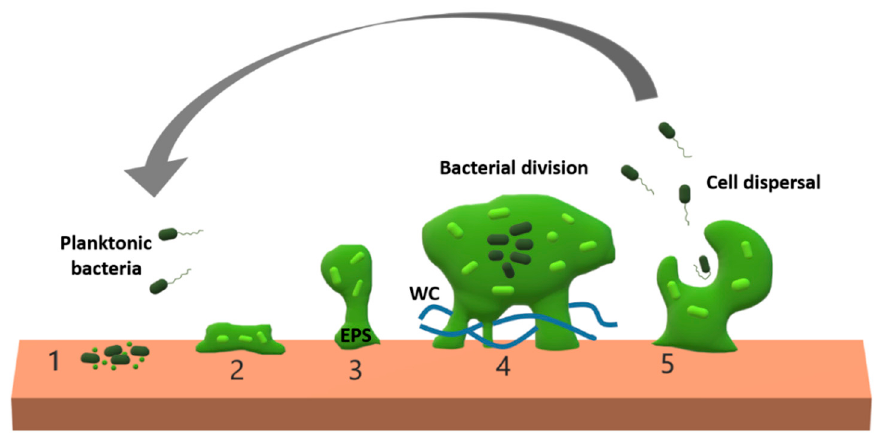
Figure 1. Schematic representation of biofilm formation. 1. Planktonic bacteria establish their initial adhesion to a surface. 2. The cells start to produce an extracellular polymeric substances (EPS) matrix and divide. 3. The bacterial population grows, increasing the bacterial density, and activating quorum sensing signaling-depending processes. 4. Quorum sensing regulates the development of specialized cells and division of labor. The biofilm matrix contains extracellular enzymes and water channels (WC), that facilitate access to nutrients. 5. Activation of biofilm disruption. Some cells can disperse and initiate new biofilms. Note that biofilms can be formed by multiple species of bacteria.